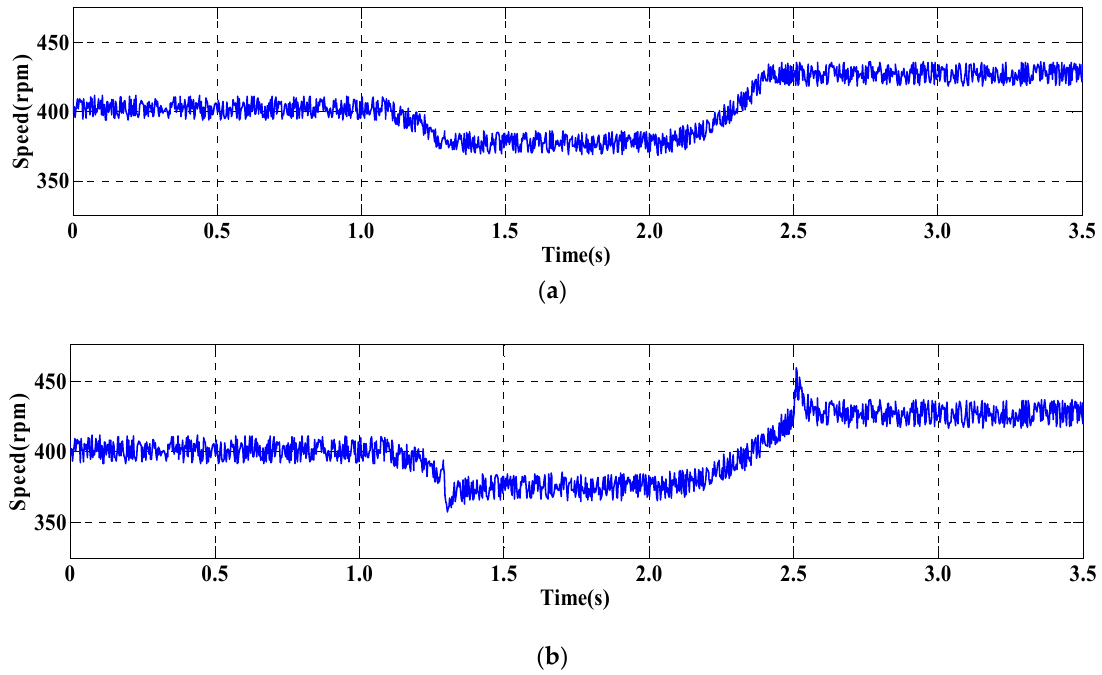
Figure 11. Dynamic performance of PMIWM. ( a ) FTSMC, ( b ) SMC.